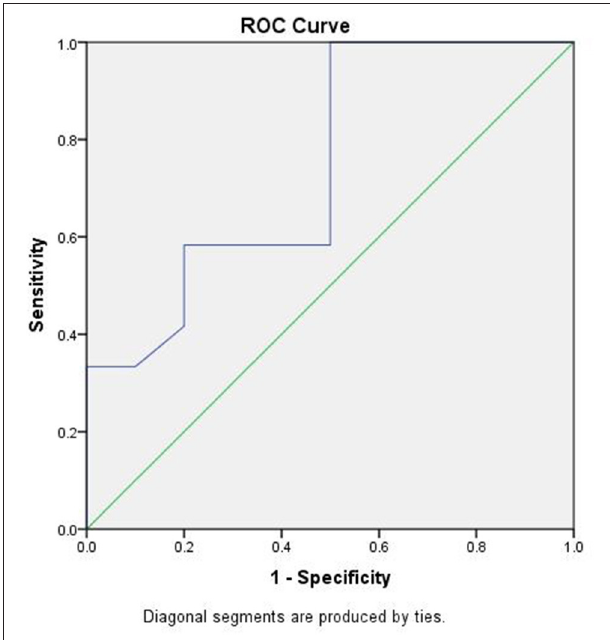
FIGURE 1 | Receiver operater characteristic (ROC) curve of gestational age (GA) at repeat cerclage (RC) predicting delivery ≥ 28 weeks of gestation. The area under the curve (AUC) is 0.746. GA ≥ 22.3 weeks at RC had a sensitivity of 100% and specificity of 50%.